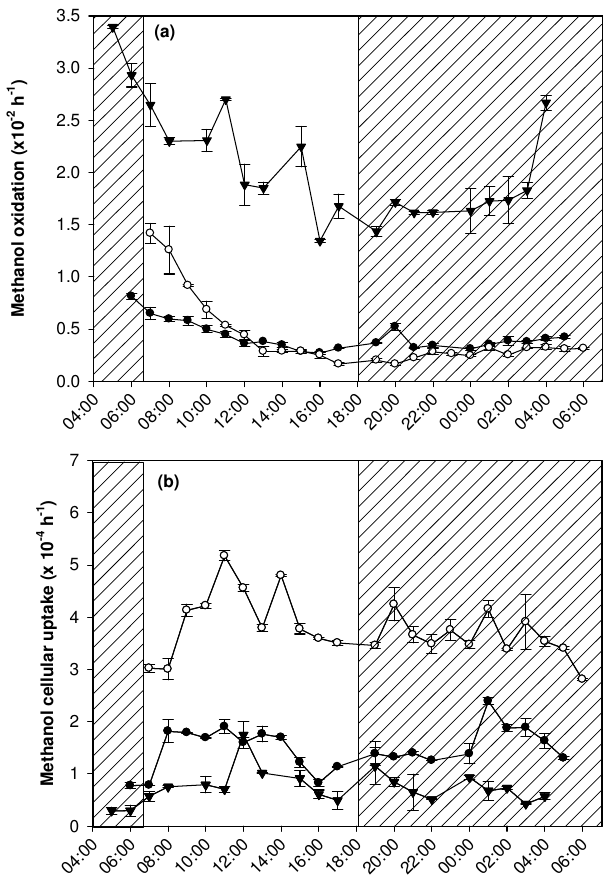
Fig. 2. Methanol oxidation (a) and uptake into particles (b) for sta- tions 1 ( H ), 2 ( • ) and 3 ( ◦ ). The hatched area shows night measure- ments and error bars represent ± 1 standard deviation of 3 replicate samples. Time in